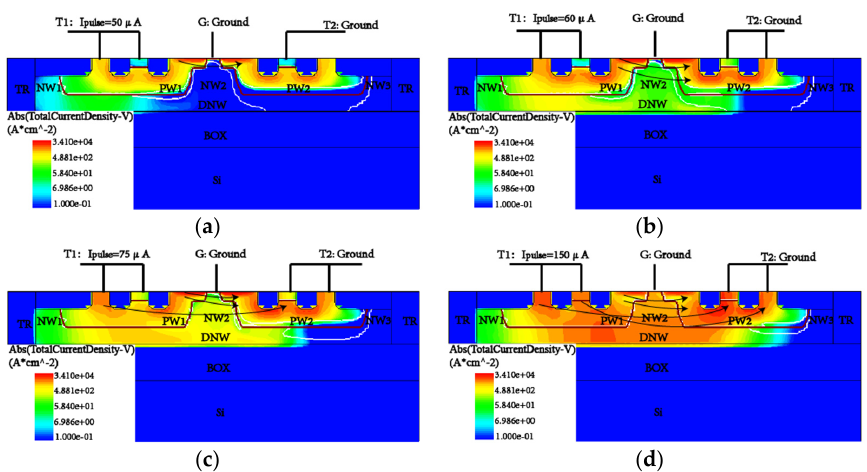
Figure 3. TCAD-simulated current density distribution of PTBSCR (L = 0.5 μ m) at different levels of current when T2 and G are grounded. The T1 is subject to ( a ) I pulse = 50 μ A, ( b ) I pulse = 60 μ A, ( c ) I pulse = 75 μ A, ( d ) I pulse = 150 μ A.